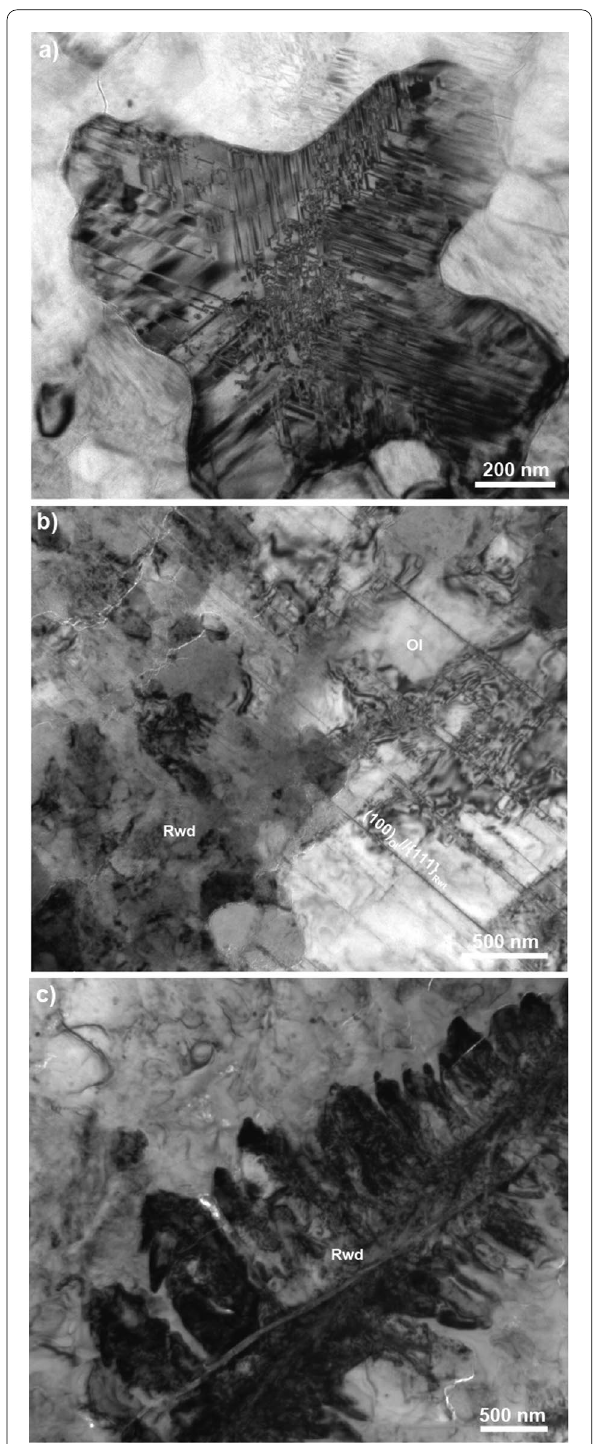
Fig. 4 Bright-field (BF)-TEM images of ringwoodite. a A ringwoodite crystal with a dense stacking fault in the Y-790729 L6 ordinary chondrite. b An olivine grain replaced with ringwoodite in the Y-791384 L6 ordinary chondrite. A part of the olivine grain in contact with the shock-melt vein is replaced with polycrystalline ringwoodite. Also, thin layers of ringwoodite occur in the olivine grain. The (100) of olivine is parallel with the {111} of ringwoodite. c A ringwoodite crystal with a dendritic texture in the Y-74445 L6 ordinary chondrite. Ol: olivine, Rwd: